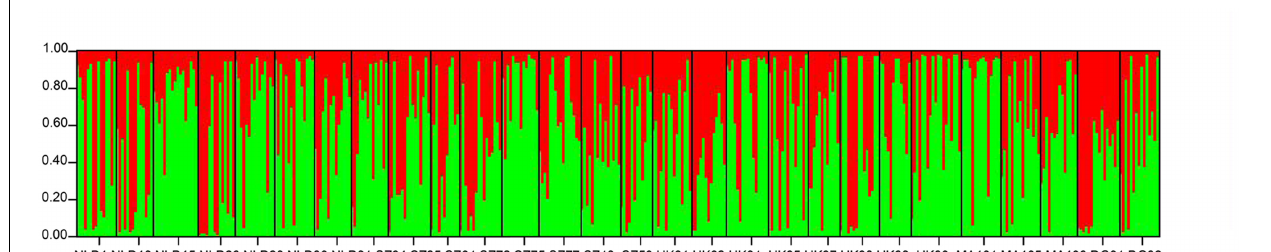
FIGURE 2 | Chloroplast genetic structure of M. micrantha populations based on structure. Each color represents a different cluster. Black lines separate populations. For population codes see Table 2 .